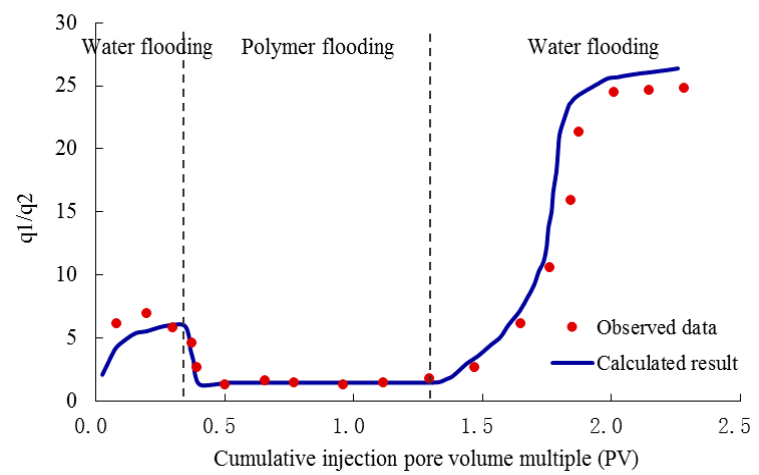
Figure 5. Comparison of flow rate ratio of No. 1 to No. 2 sand pack between observed and calculated results.